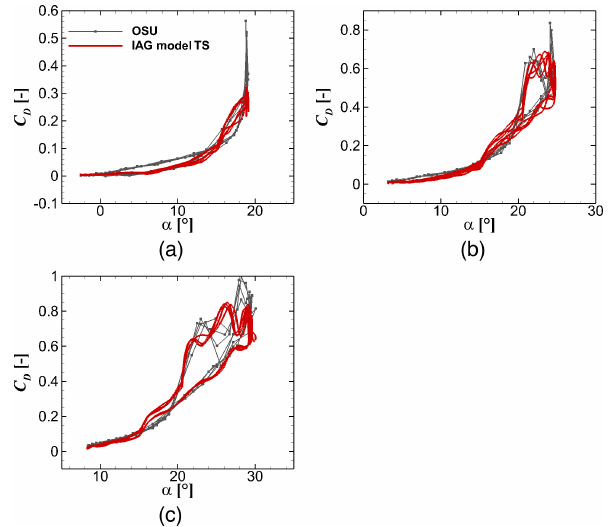
Figure 13. Drag reconstruction by the IAG model in comparison with the measurement data (Ramsay et al., 1996) for (cid:49)t = T/ 1440 using the actual angle of attack in the experimental campaign at various α values. From (a) to (c) : α = 8, α = 14 and α = 20 ◦ . S801 airfoil, k = 0 . 073 and (cid:49)α = 10 ◦ .